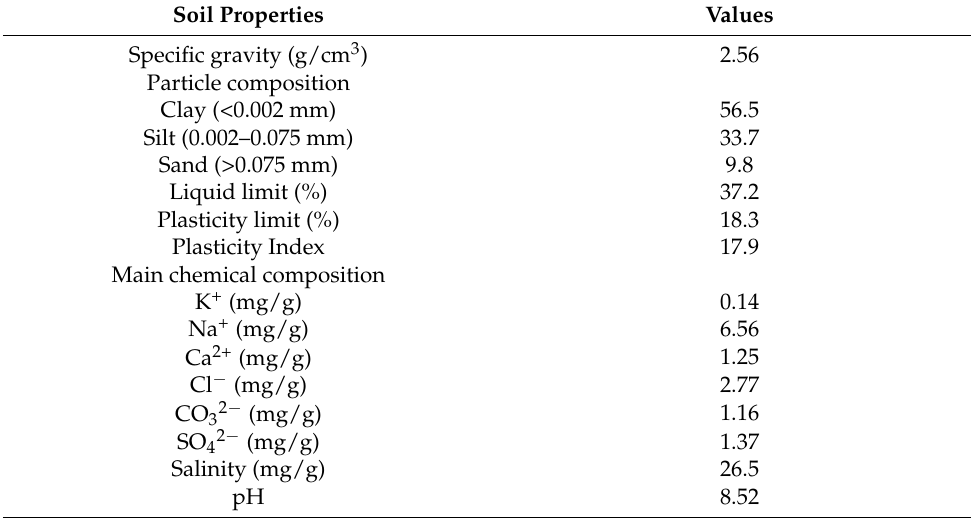
Table 1. Basic physical properties of the soil. Soil